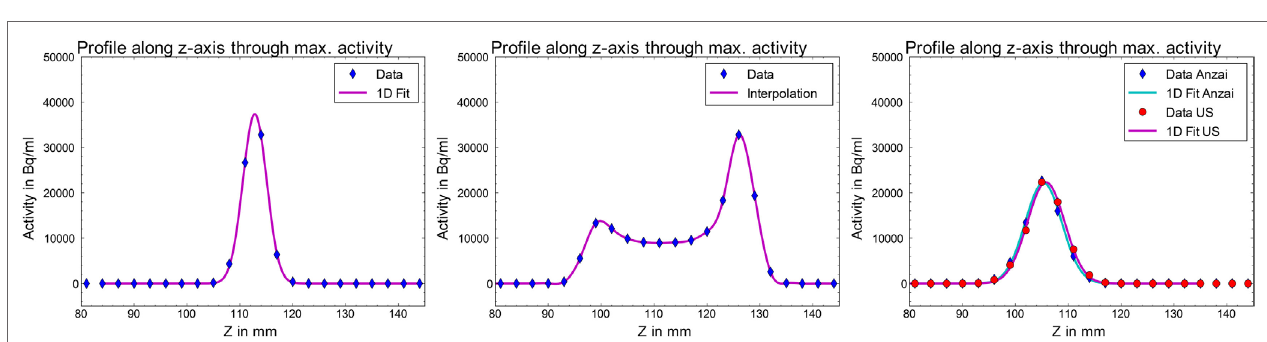
FigUre 6 | activity profiles of static ( left ) and moving (cosine 4 ) point source in PeT images . Middle: the activity of the source is smeared over the whole motion amplitude (here 3 cm) if not corrected for. Right: using the 4D gated reconstruction based on the breathing belt (blue rhombi) as well as the ultrasound (red dots) signal, the Gaussian shape and integral activity can be